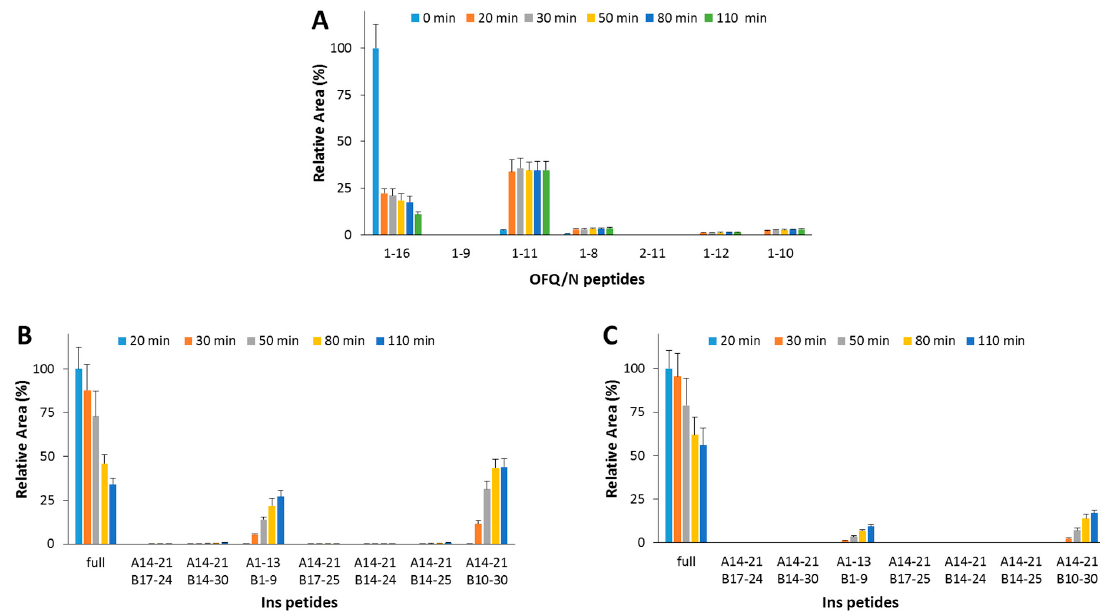
Figure 4. Hydrolytic pattern of the time-course OFQ / N ( A ) degradation catalyzed by IDE at 37 ◦ C. OFQ / N was incubated with IDE for 20 min at 37 ◦ C before the addition of Ins. The kinetic profile of the Ins degradation was analyzed when IDE was pre-incubated alone ( B ) or with OFQ / N ( C ) at 37 ◦ C for 20 min.